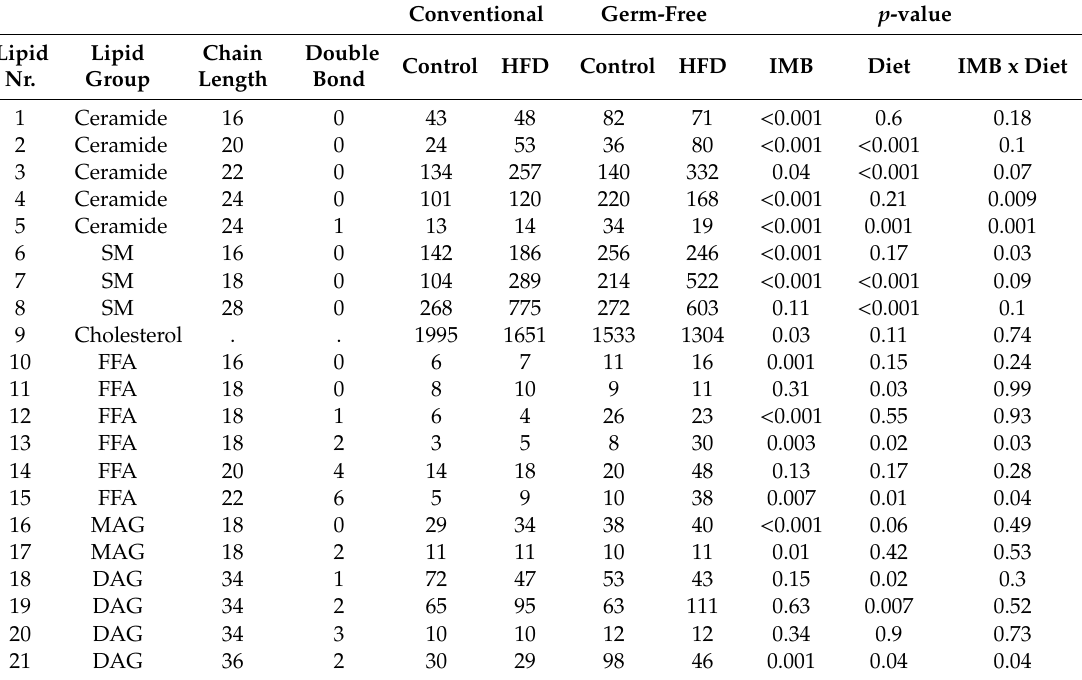
Table A1. Quantification of the total amount of lipids found per lipid identified by mass spectrometry, as calculated by peak area intensity from the UPLC